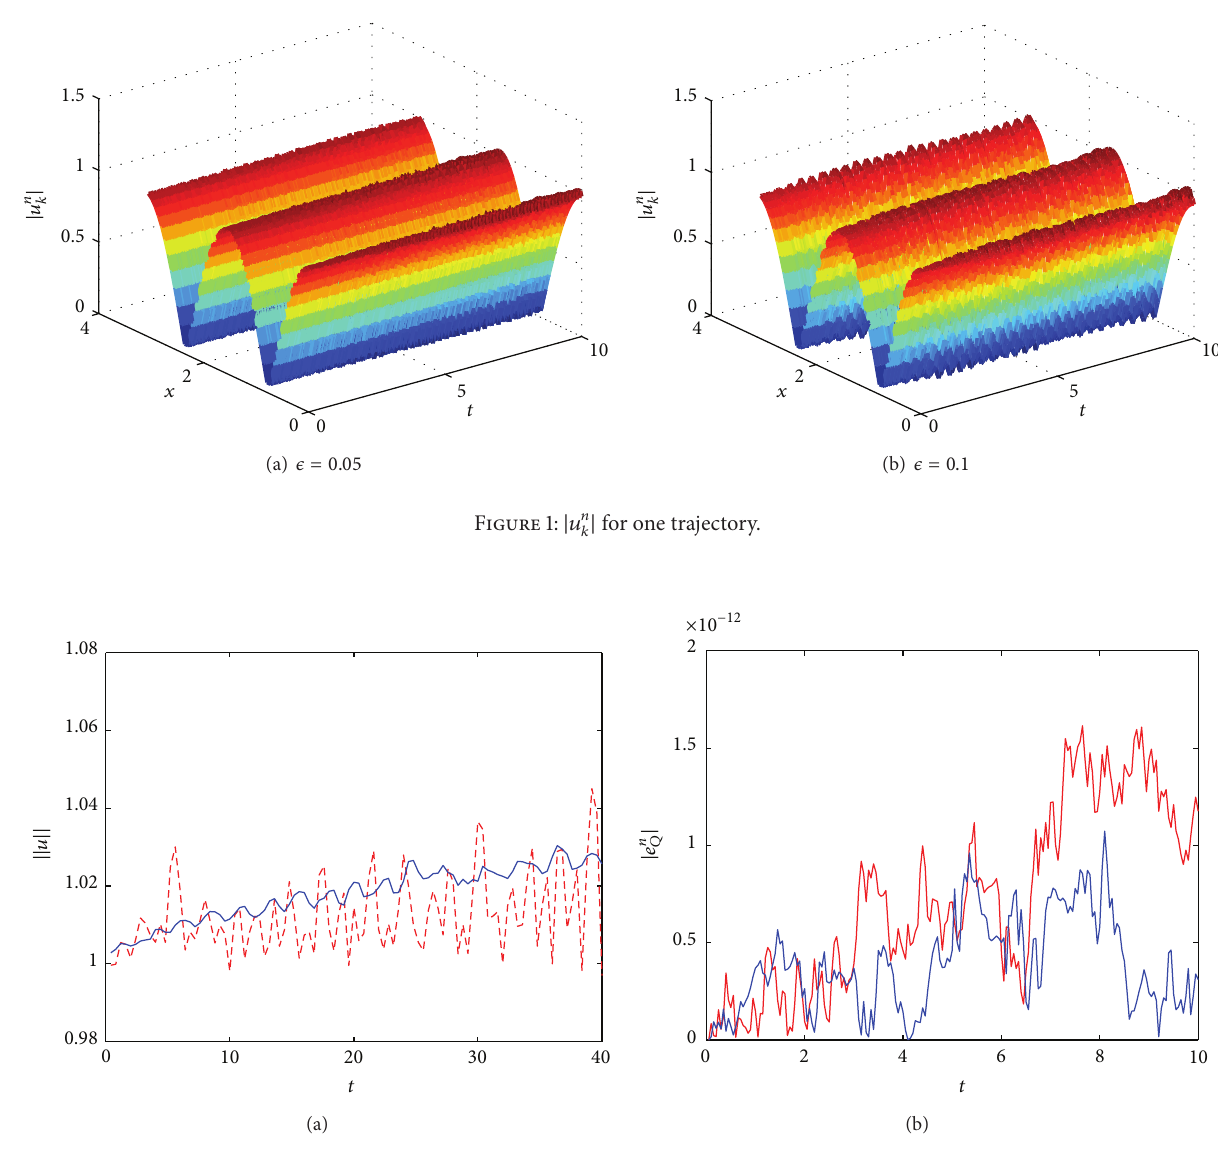
Figure 2: ‖𝑢‖ ∞ for one trajectory and the average norm over 50 trajectories (a). Residuals of discrete charge for one trajectory